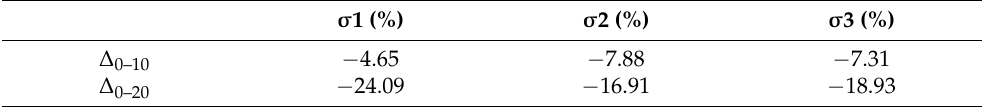
Figure 11. Hydrodynamic performance at different oblique angles and cavitation numbers. ( a ) Hydrodynamic parameters at different oblique angles and cavitation numbers. ( b ) Difference of the hydrodynamic parameters. Table 9. Difference at different cavitation numbers.